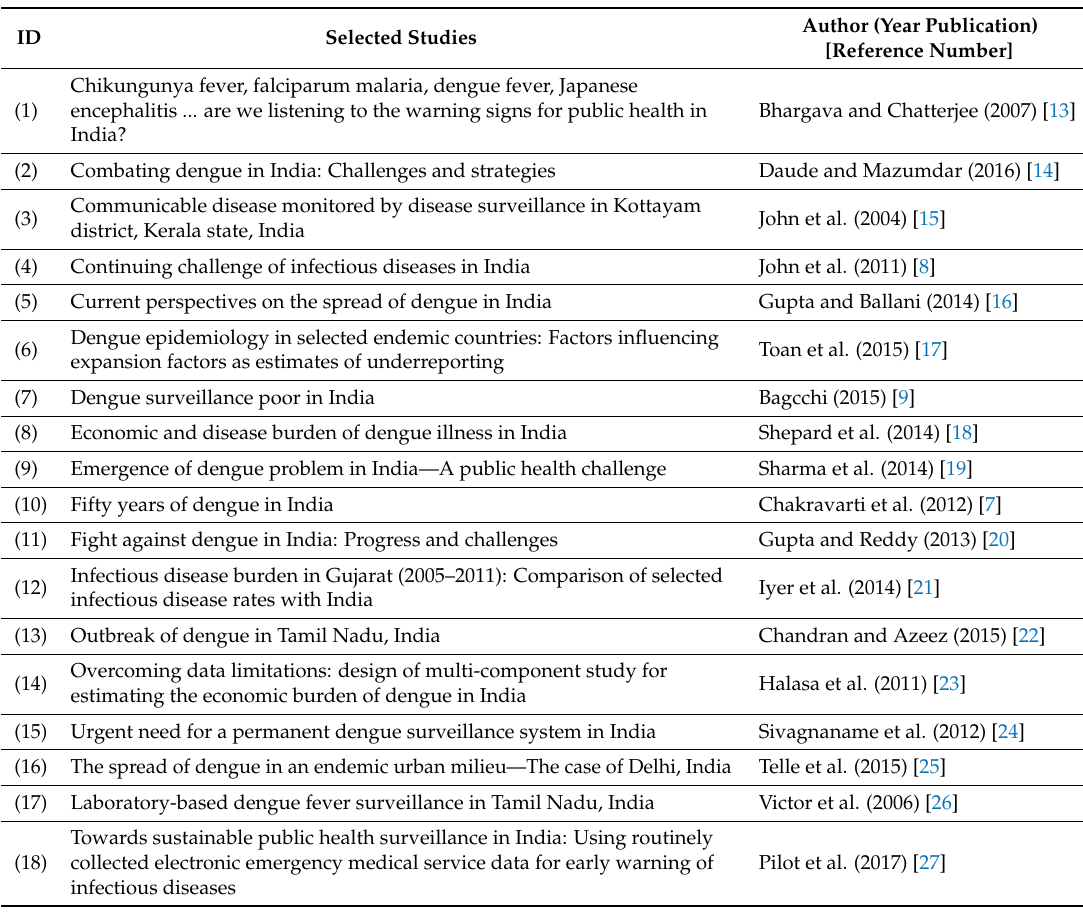
Table 1. List of selected publications on organization, implementation and functioning of dengue surveillance in